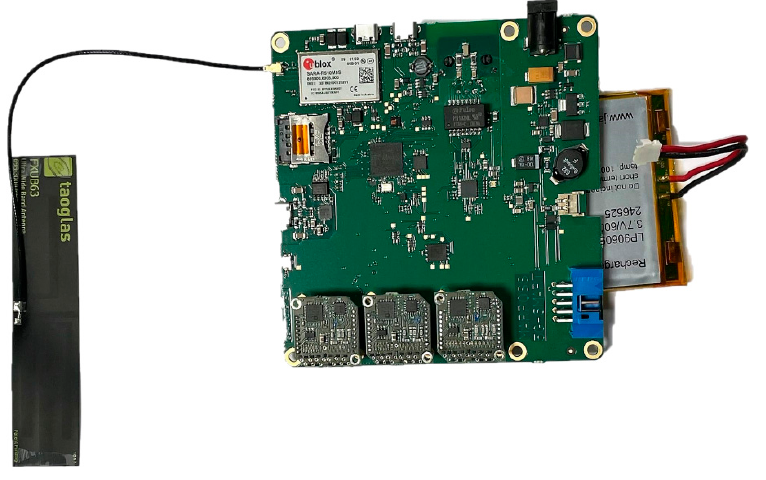
Figure 3 . MSP hardware prototype . Figure 3. MSP hardware